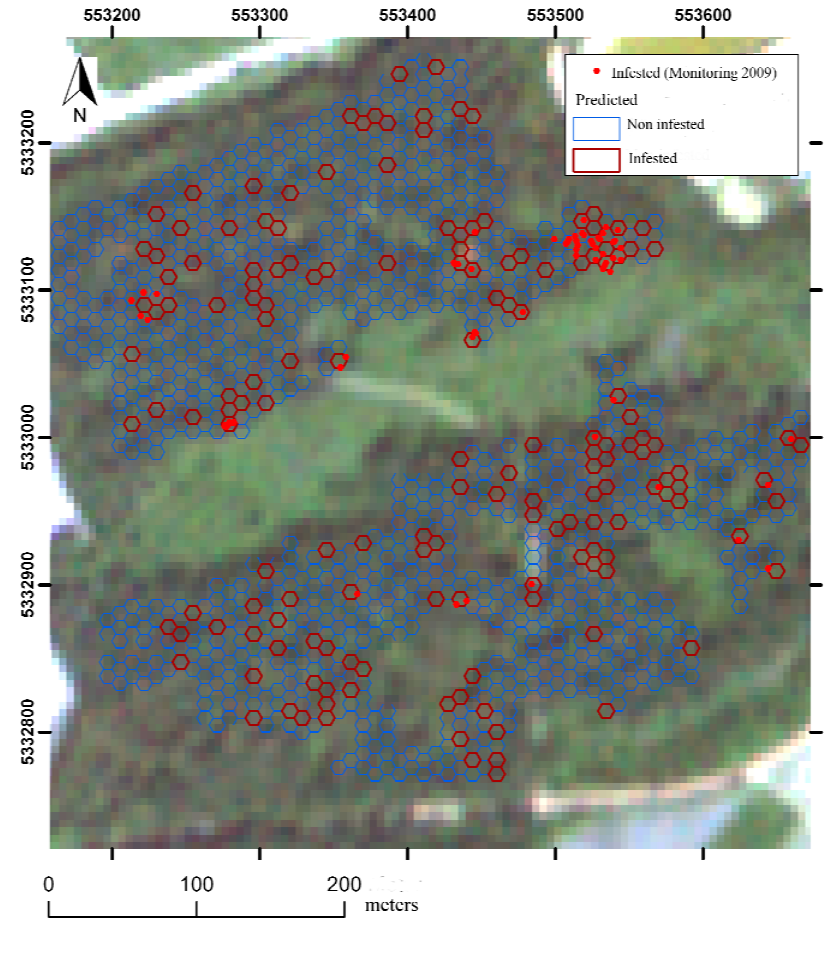
Figure 3. Multisensor ME prediction map for bark beetle green attack (RapidEye image in